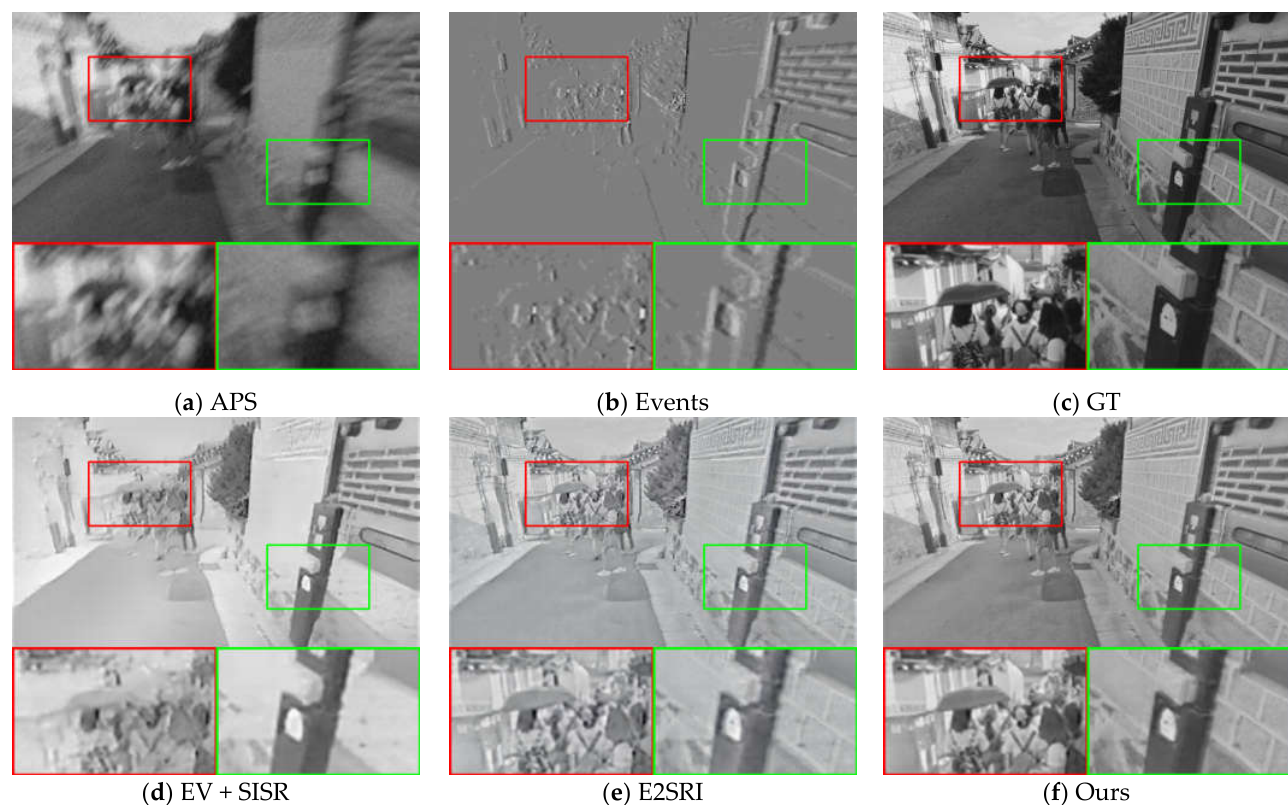
Figure 4. Comparison of the visual quality of our proposed method with other state-of-the-art methods for 2× SR on synthetic datasets. The APS frame and event stack are upsampled with bicubic interpolation to the corresponding scale for reference.